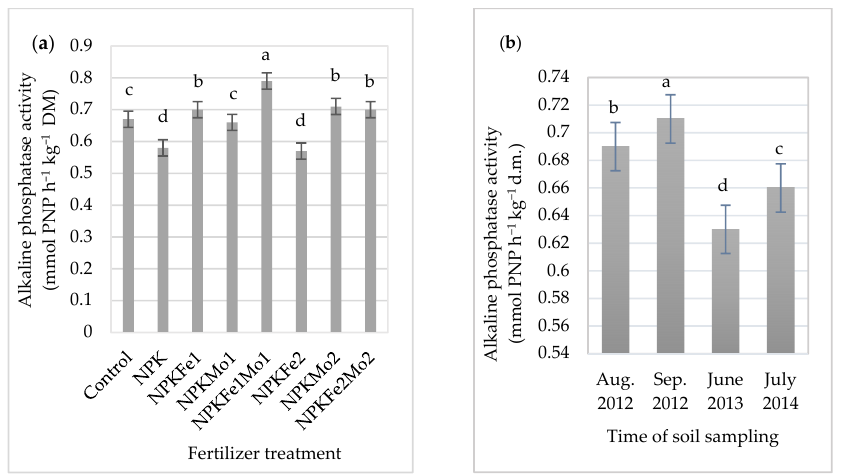
Figure 4. The effects of mineral fertilizer treatment ( a ) and time of soil sampling ( b ) on alkaline phosphatase activity. Each bar represents the mean ± SE. The same letters mark no significantly different values ( p ≤ 0.05).